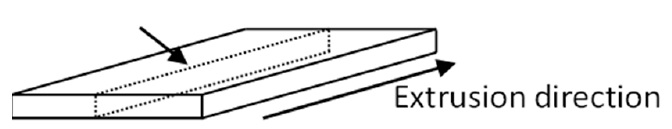
Figure 2. Schematic showing the position of the microtomed sample within the tape.